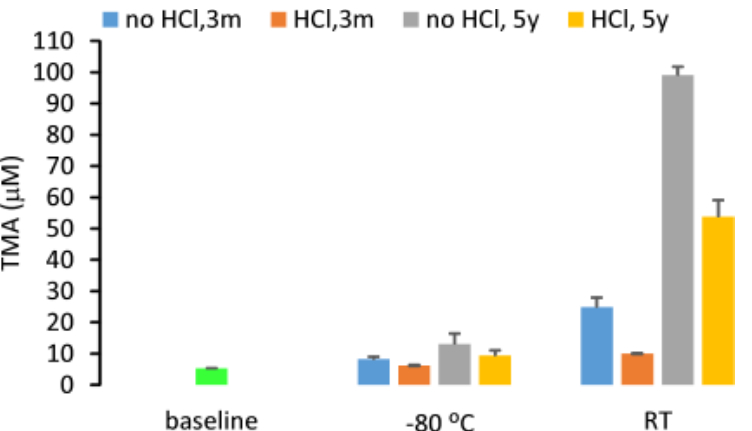
amount of d9-TMA as an internal standard. Data were presented as mean±SD from three replicates.